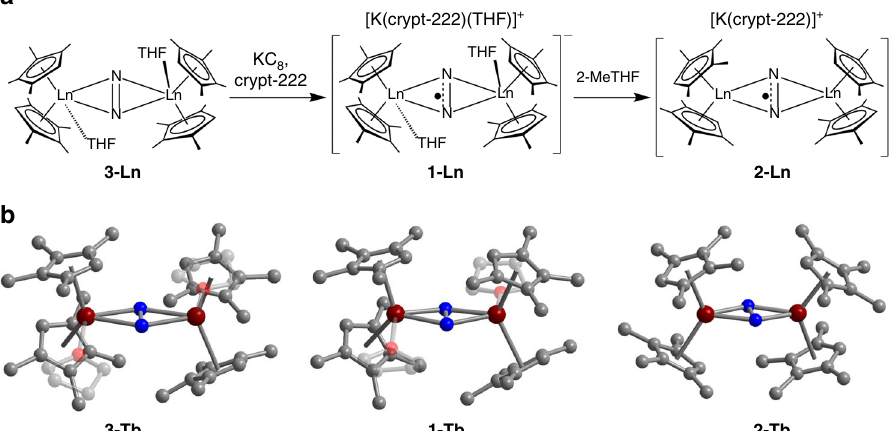
Fig. 1 Synthesis and molecular structures of radical complexes. a Synthetic scheme for 1-Ln and 2-Ln . b Structure of the non-radical N 2 2 – -bridged complex 3-Ln , and structure of the N 2 3 − radical-bridged anions in crystals of 1-Ln and 2-Ln . Dark red, red, blue, and gray spheres represent Tb, O, N, and C atoms, respectively; H atoms have been omitted and THF groups faded for clarity. Selected interatomic distances (Å) and angles (deg) for 1-Gd , 1-Tb , and 1-Dy , respectively: N – N = 1.362(9), 1.371(6), 1.374(3); mean Ln – N = 2.288(8), 2.257(4), 2.236(2); Ln ··· Ln = 4.344(1), 4.294(3), 4.244(1); Ln – N – N – Ln = 173.3 (3), 173.4(3), 173.1(1). Selected interatomic distances (Å) for 2-Tb and 2-Dy , respectively: N – N = 1.392(9), 1.389(12); mean Ln – N = 2.221(6), 2.226(8); Ln ··· Ln = 4.216(1), 4.230(1); Ln – N – N – Ln = 178.3(3),